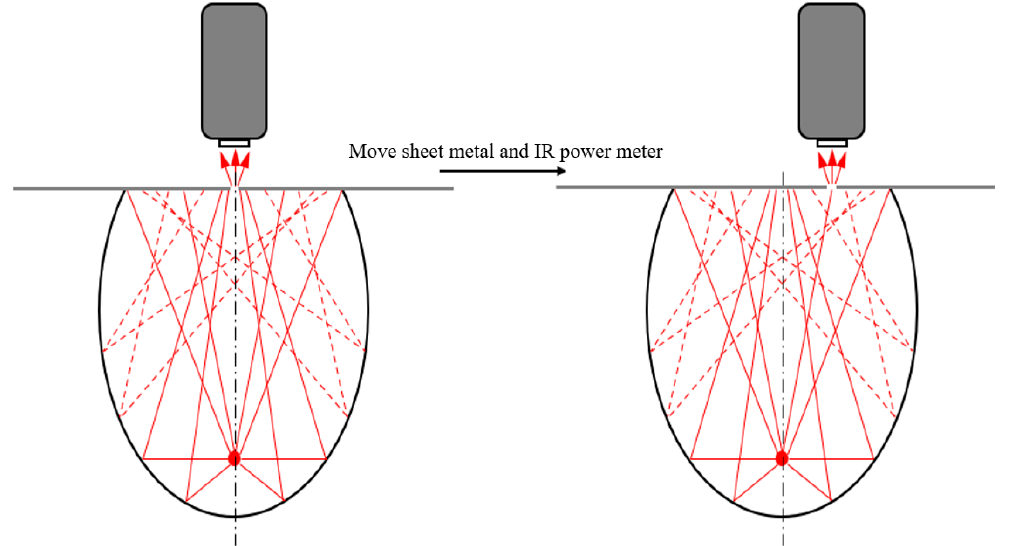
Figure A2. Measurement process of IR intensity.